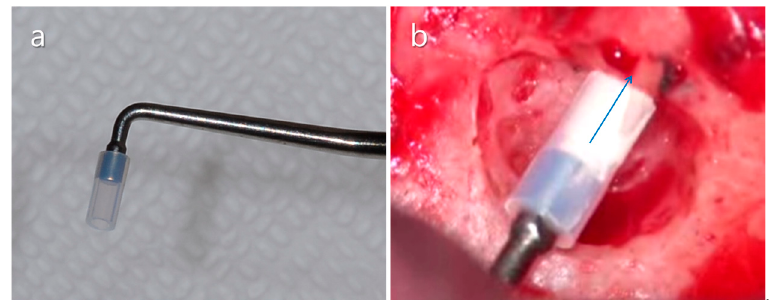
Figure 19. Manual carrier for MTA application. ( a ) Assembled Teflon sleeve and plugger. ( b ) Clinical application of MTA into root-end cavity prepared in the buccal root of the mandibular first molar using the manual carrier. A blue arrow indicates the direction of the force of the plugger.